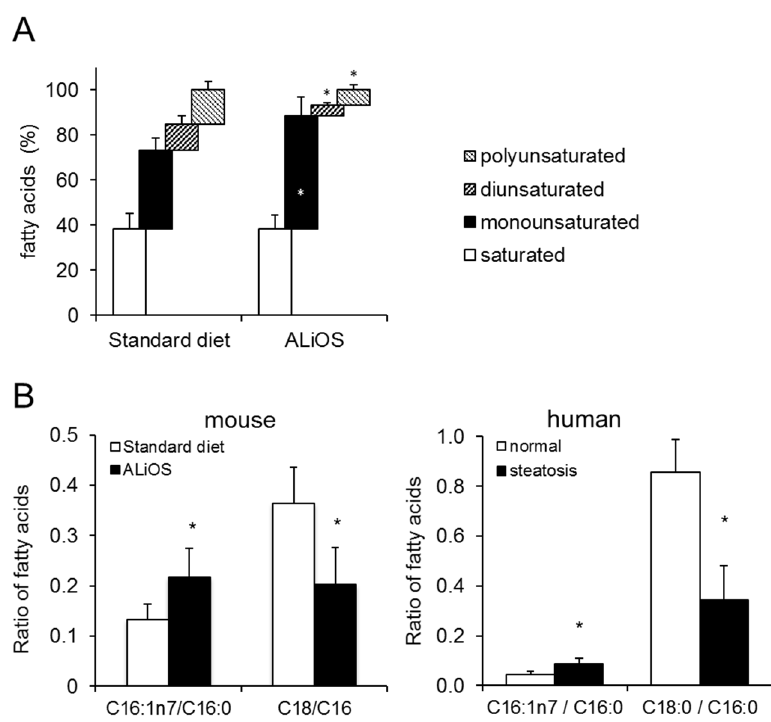
Figure 2. Comparison of the liver lipidome in murine and human NAFLD. ( A ) Wildtype mice were fed standard diet or ALiOS diet for 24 weeks. Liver lipidome was characterized by gas chromatography (GC) as described. Composition of the lipidome is depicted in categories of saturated, monounsaturated, diunsaturated and polyunsaturated fatty acids. ( B ) Fatty acid composition of mouse and human livers without steatosis (white bars) and with steatosis (black bars) was determined. Previously described fatty acid ratios associated with NAFLD are depicted (mean ± standard deviation; n = 5 for mouse, n = 9–10 for human liver tissue; * p < 0.05; t-test).